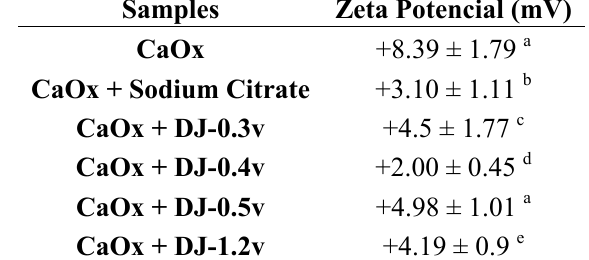
Table 3. Zeta Potential characteristics of crystals with treatment of sulfated polysaccharides from brown seaweed Dictyopteris justii at temperature 25 °C. a, b, c, d Different letters indicate a significant difference ( p < 0.05). Zeta potential between each sample with CaOx. 1, 2, 3, 4 Different numbers indicate a significant difference ( p < 0.05). Zeta potential between each sample without CaOx.